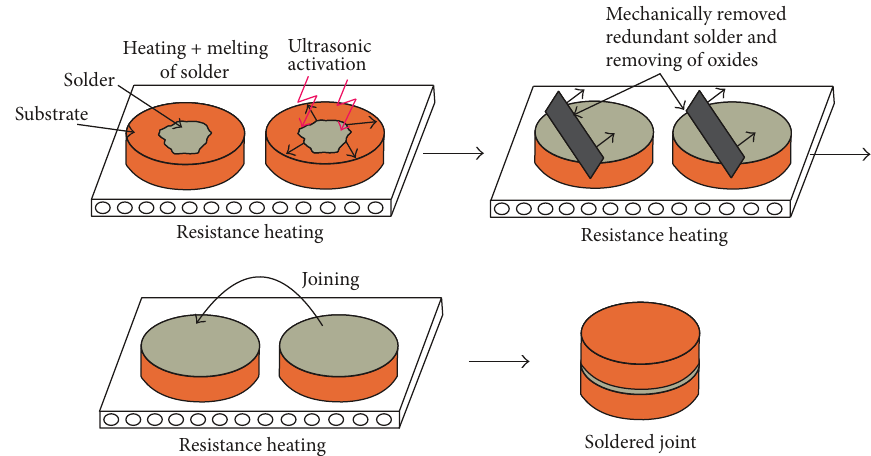
Figure 3: Procedure of joint fabrication by ultrasonic soldering.